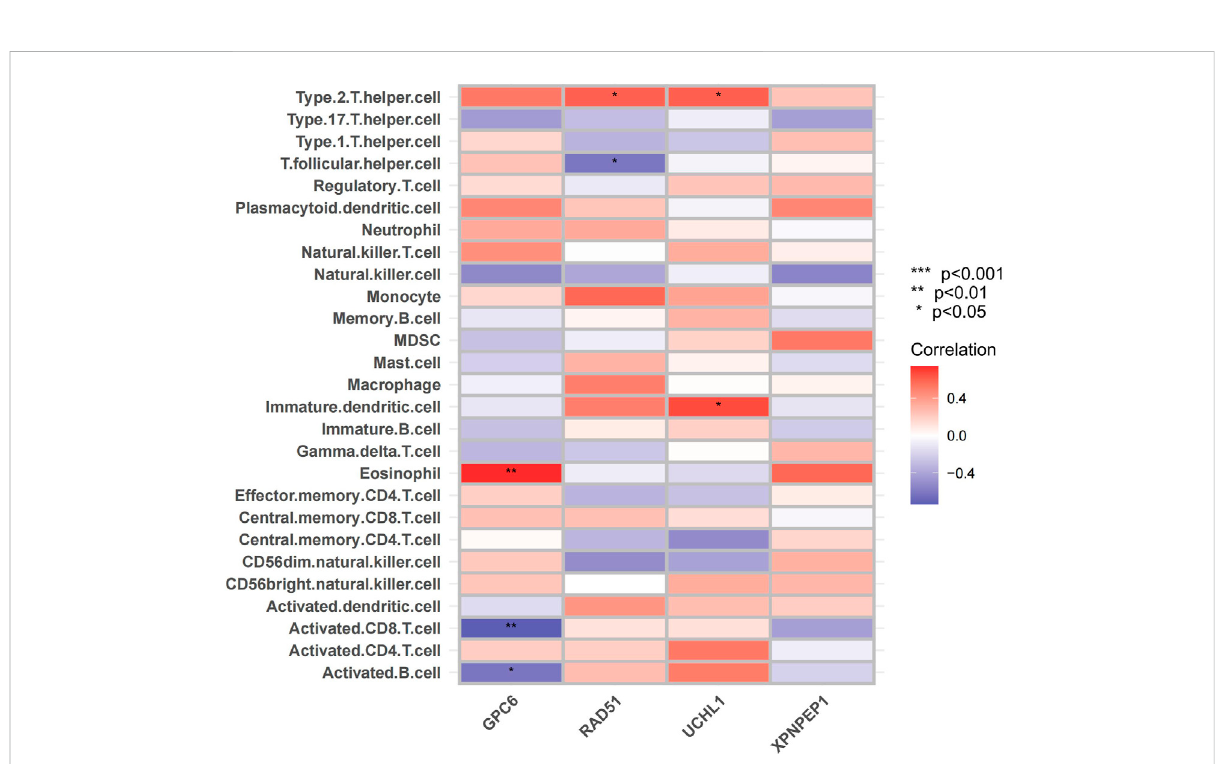
FIGURE 11 Immune cell in fi ltration analysis. The correlation analysis between immune cells: The red square represents positively correlated with upregulated immune cells. The bule square represents negatively correlated with decreased immune